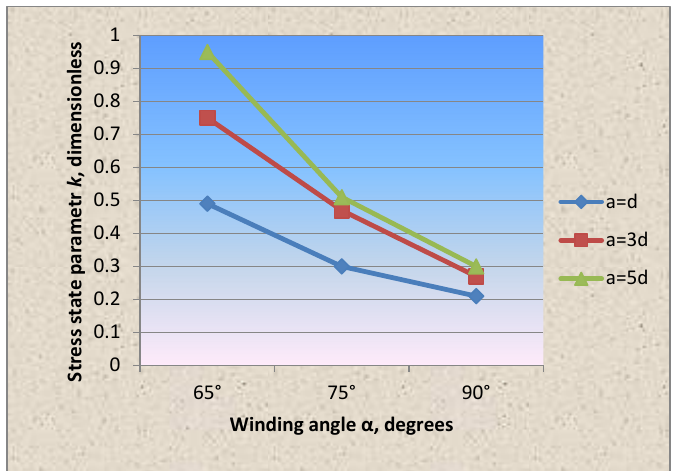
Figure 7. Dependence of the stress state parameter on the winding angle of the wrapping thread with the winding wire diameter of 2.0 mm. Comparison of the circumferential and axial stress values from the restressing in the shell wall fragment showed the same nature of stress distribution as in the case of winding wire with a diameter of 1.0 mm.